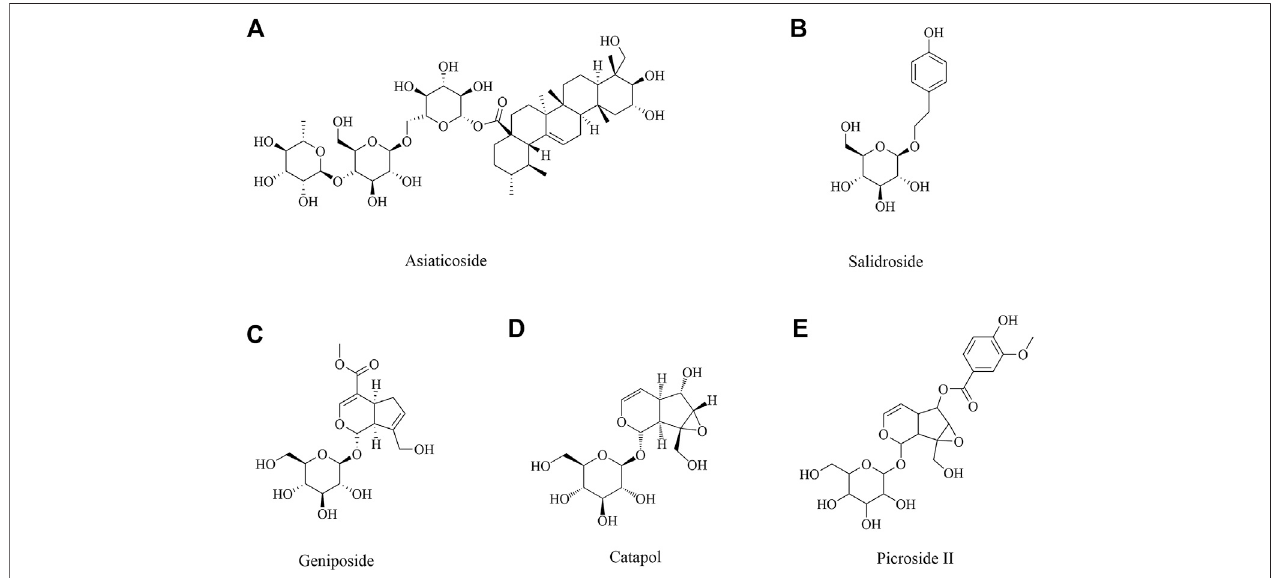
FIGURE 4 | The glucosides for cerebral ischemia